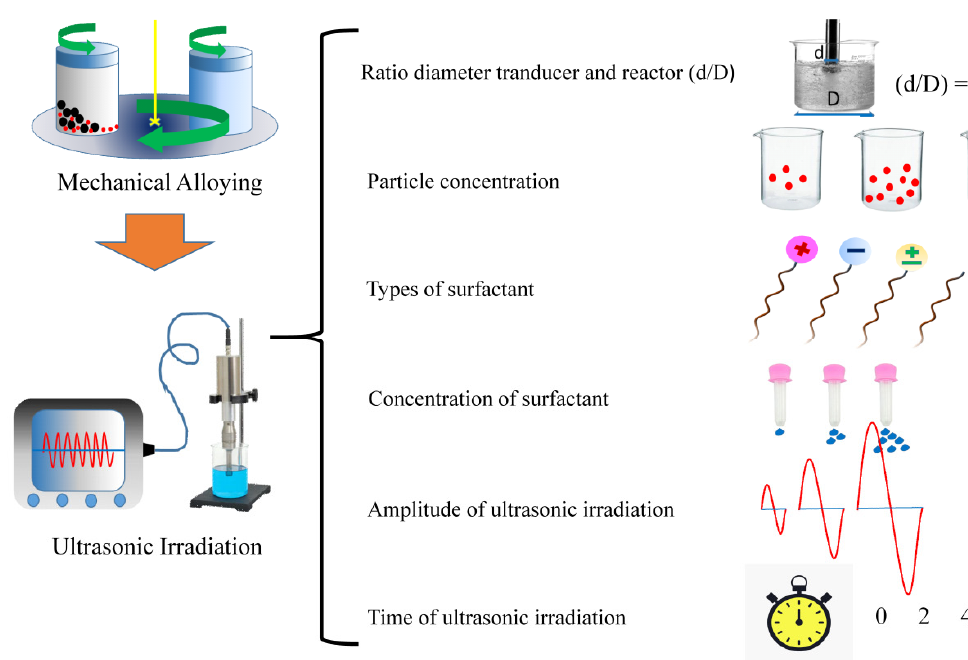
Figure 1. Schematic illustration of the combined destruction process.